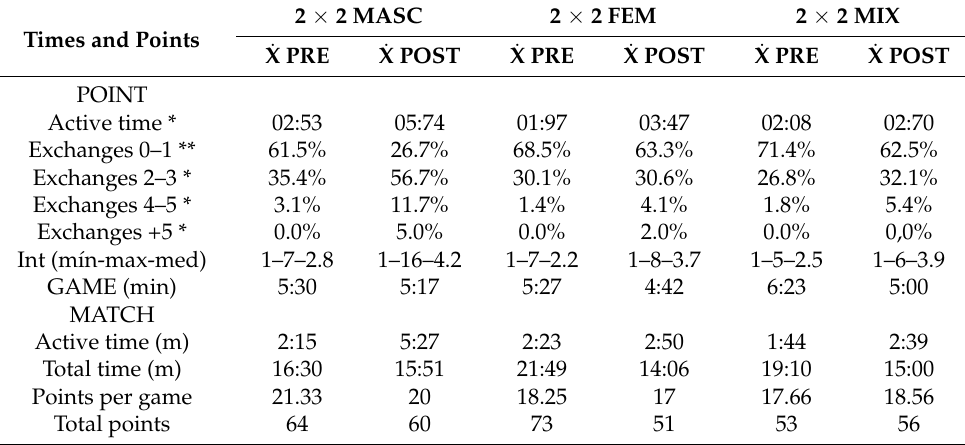
Table 6. Score, exchanges and average duration points, games and matches pre- and